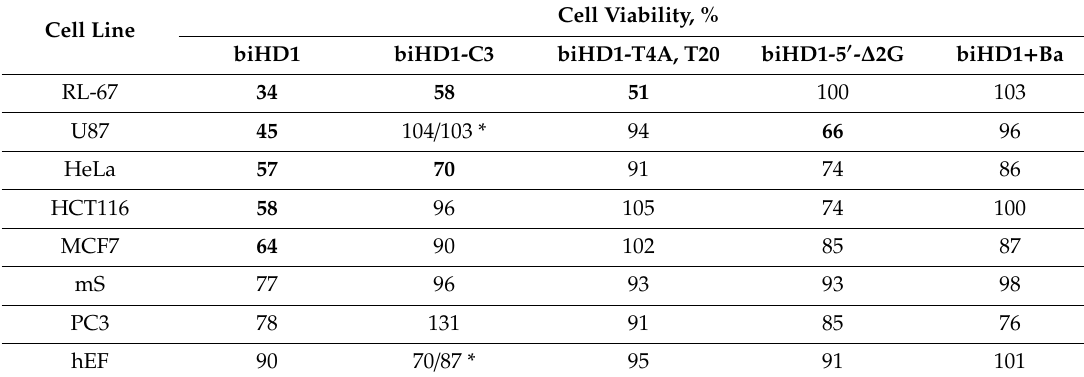
Table 2. Cell viability after treatment of human cancer cell lines and control cell line with ‘standard’ concentration of oligonucleotides, 10 µ M. The cell line is listed according to the cell viability after biHD1 treatment. The viability values with less than 70% are in bold. All data could be found in the Supplement Figures S2–S8. In the biHD1-C3 column, * marks the data for the single-modular HD1.